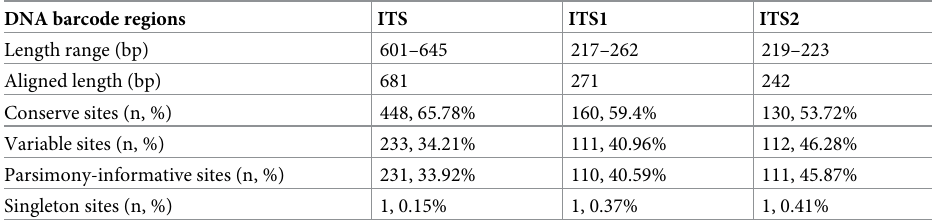
Table 4. Properties of the ITS, ITS1, and ITS2 barcoding regions of B . alnoides , S . axillaris , and Z . attopensis . DNA barcode regions ITS ITS1 ITS2 Length range (bp) Conserve sites (n, %) Variable sites (n,